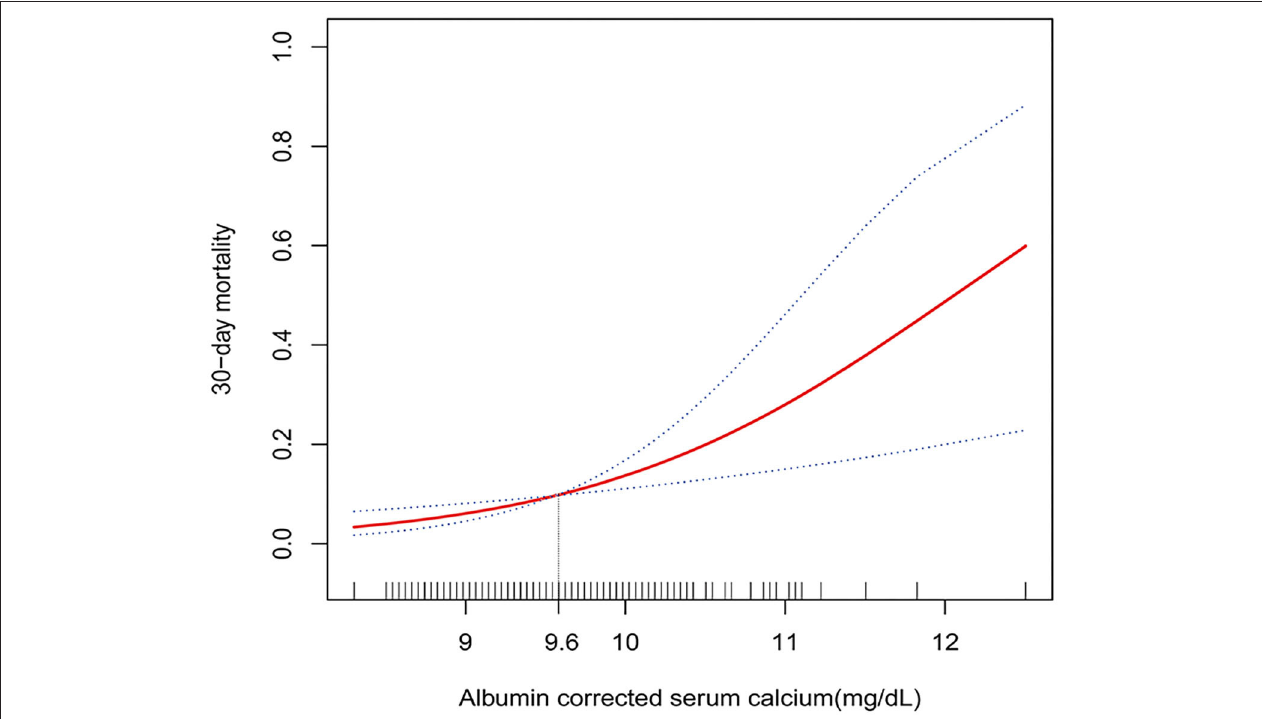
FIGURE 2 | Multivariate adjusted smooth curve-fitting for association between ACSC and 30-day mortality. Same confounder factors as in model III: age, gender, serum glucose, serum-phosphate tertiles, serum-magnesium tertiles, atrial fibrillation/atrial flutter, renal insufficiency, heart failure, chronic obstructive pulmonary disease, cancer, pneumonia, paralysis, aphasia, cognitive disorder, and epilepsy, were adjusted. The red line represents the best-fit line, and the blue lines are 95% CIs. The potential demarcation point was 9.6 mg/dl according to the smoothing spline